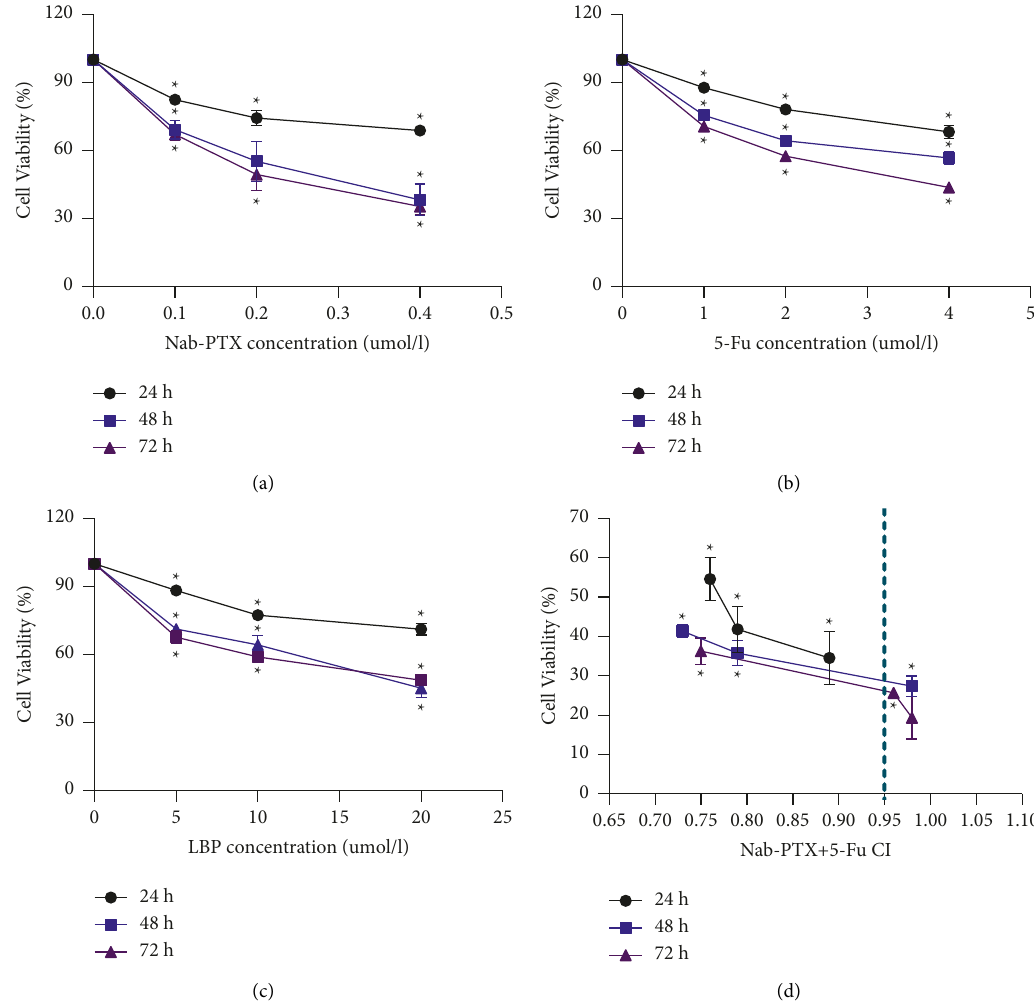
Figure 1: CCK8 assay to detect the cell inhibition rate of each group and each time period. (a) Nab-PTX (concentration gradient: 0.1 μ mol/l, 0.2 μ mol/l, and 0.4 μ mol/l) for 24, 48, and 72h; (b) 5 -Fu (concentration gradient: 1 μ mol/l, 2 μ mol/l, and 4 μ mol/l) for 24, 48, and 72h; (c) LBP (concentration gradient: 5 μ mol/l, 10 μ mol/l, and 20 μ mol/l) for 24, 48, and 72h; (d) Nab-PTX+5-Fu (concentration gradient: 0.1 μ mol/l +1 μ mol/l, 0.2 μ mol/l +2 μ mol/l, and 0.4 μ mol/l +4 μ mol/l) for 24, 48, and 72h . ∗ P < 0 . 05 indicates statistical significance. Data are shown as mean ± SD of 3 wells, and it represents three independent